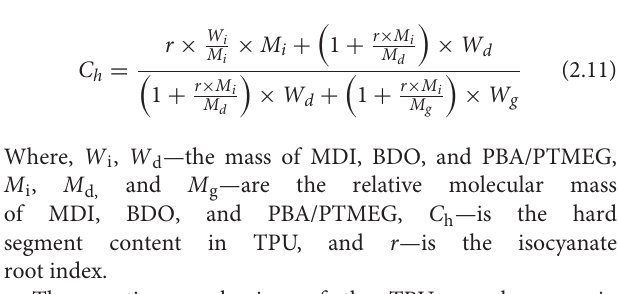
Frontiers in Materials |